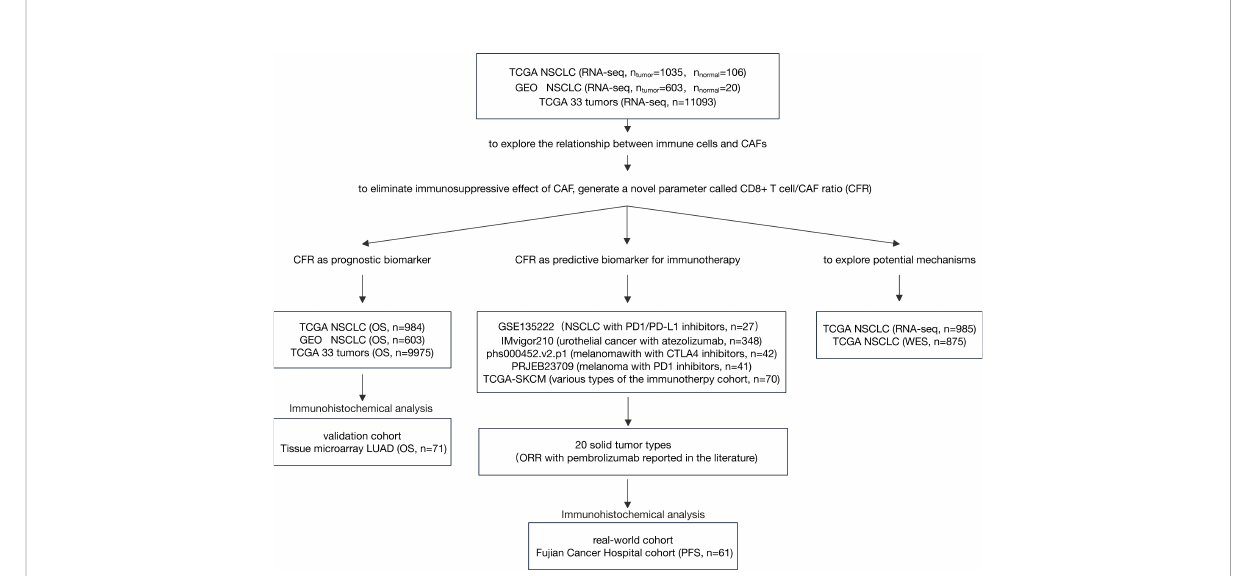
FIGURE 1 Flow diagram of the study. LUAD, lung adenocarcinoma; NSCLC, non-small cell lung cancer; IHC, immunohistochemistry; CAF, cancer- associated fi broblast; ORR, objective response rate; OS, overall